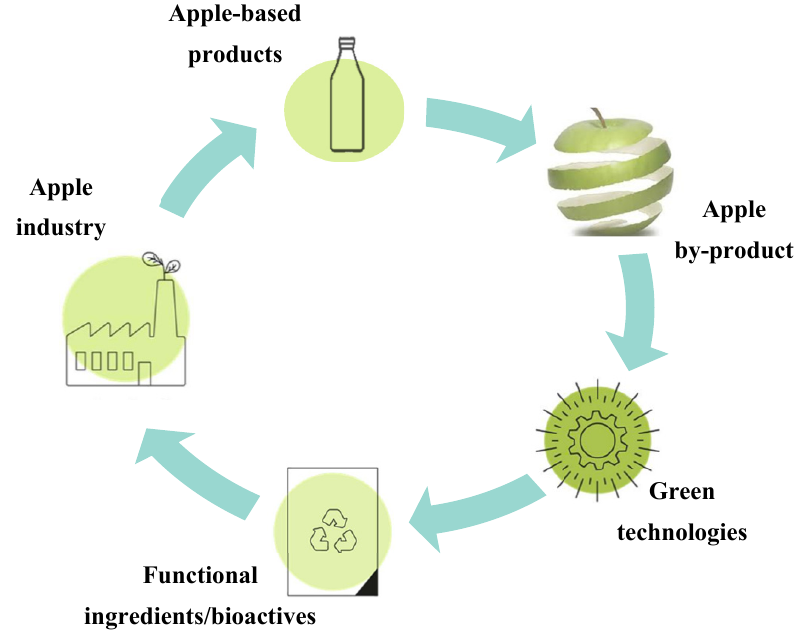
Figure 4. Apple industry based on green and sustainable technologies in the scope of circular econ- omy.